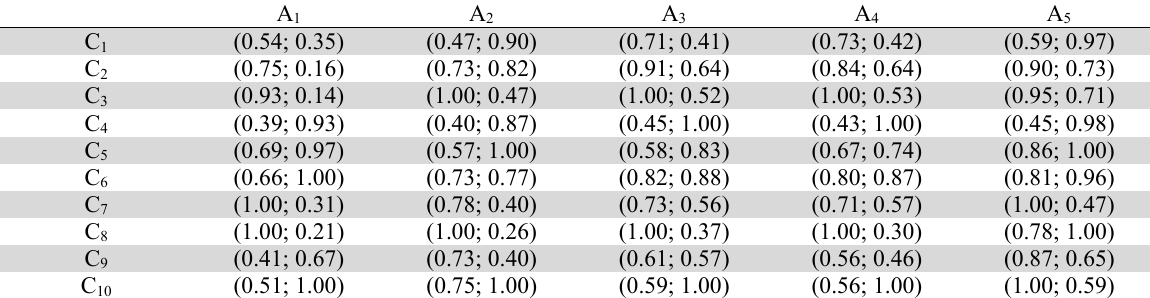
The normalized intuitionistic fuzzy valued decision